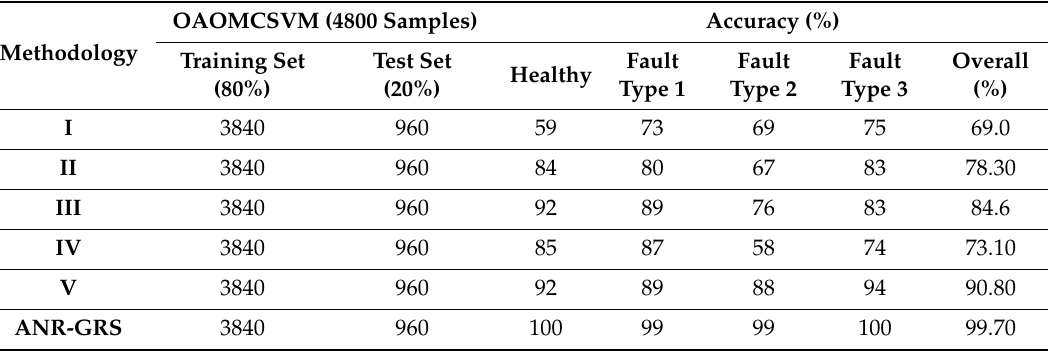
Table 4. Classification results for state-of-the-art methodologies and the proposed ANR-GRS methodology by a combination dataset of di ff erent